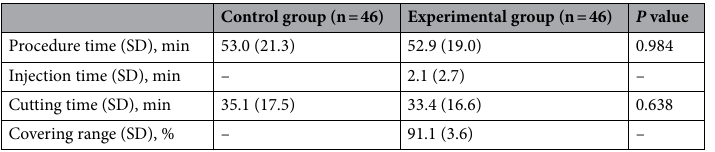
ing rates in the control group and experimental group were 5.95 ± 3.90 cm 2 versus 8.07 ± 4.97 cm 2 ( P = 0.0352) (Fig. 3c) and 73.28 ± 17.81% versus 83.89 ± 9.51% ( P = 0.0013) (Fig. 3d), which made it more convincing that this kind of protective gel could speed up ulcer healing. Furthermore, when detected by endoscopy 2 weeks later, wounds in the control group showed greater severity, accompanied by severe necrosis and oedema compared with the experimental group. We did not detect any residual gel over the ulcer bed in endoscopic re-evaluation (Fig. 4).